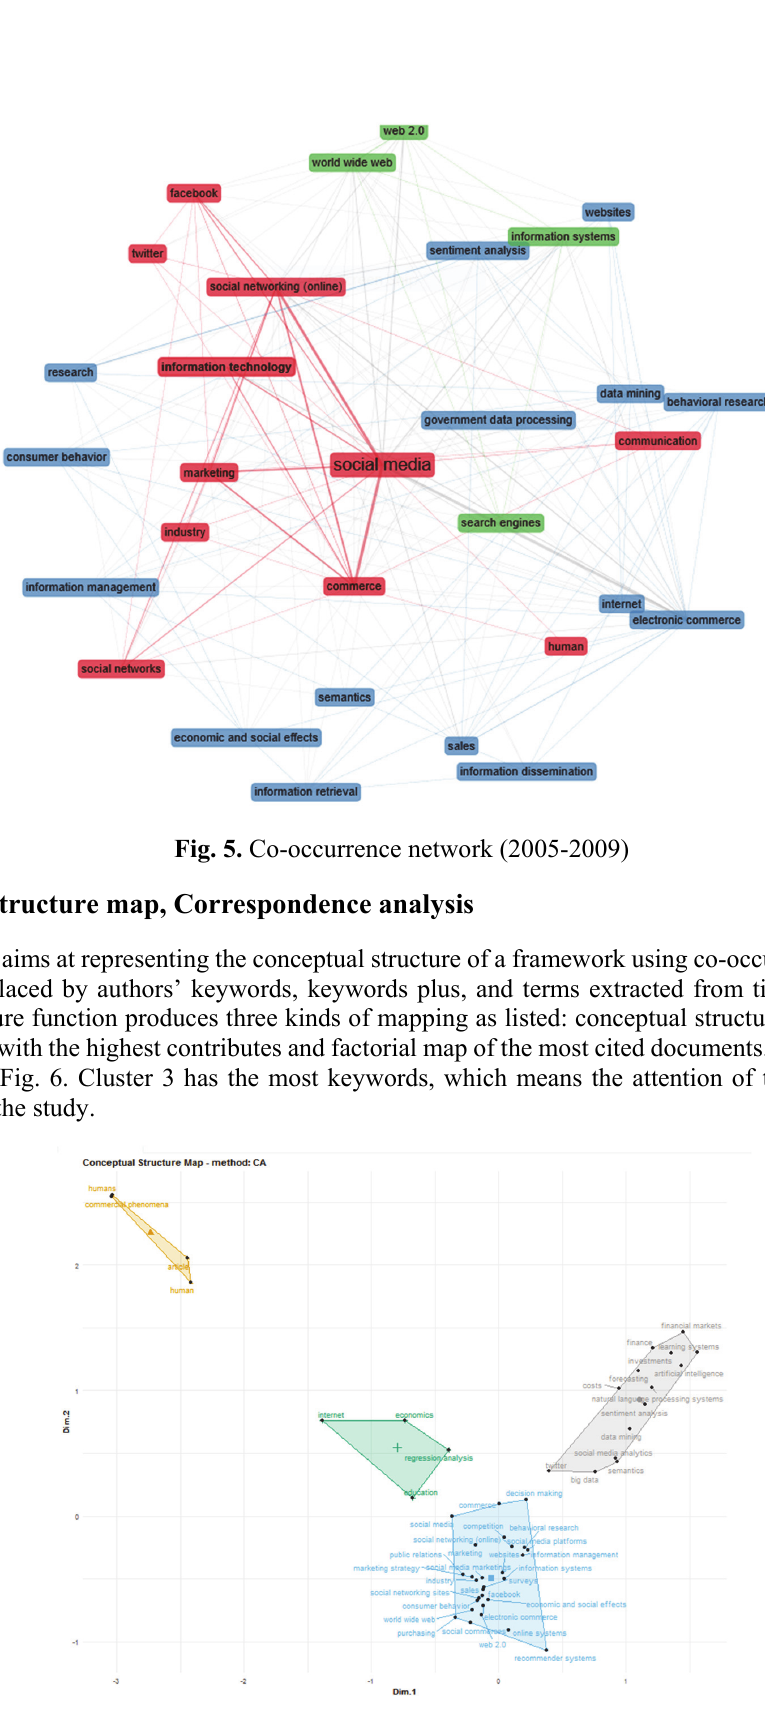
Fig. 6. Conceptual structure Map, method: